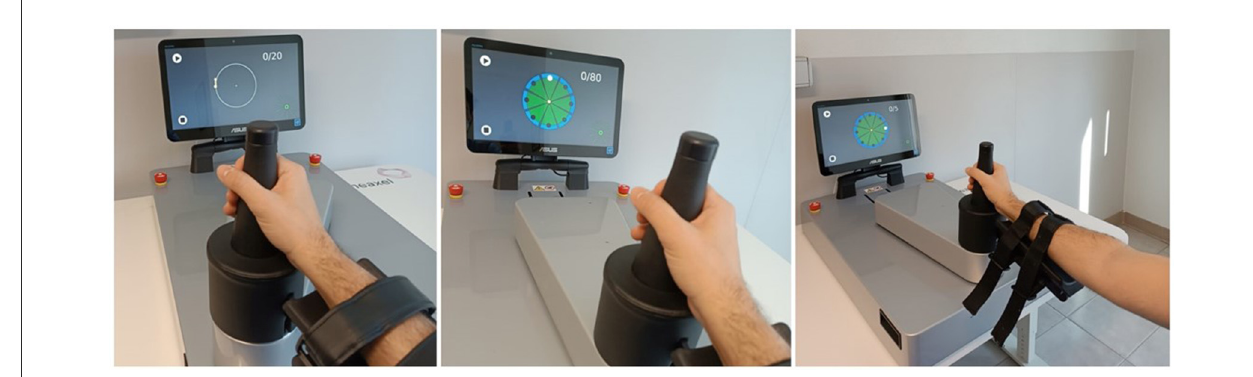
FIGURE3 Evaluation exercises: circle drawing, point to point e horizontal abduction/adduction.